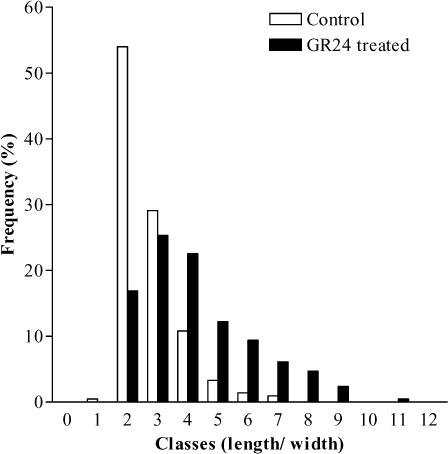
Effect of GR24 on Size of Mitochondria in Hyphae of
Gl. intraradices Stained with Mitotracker Green
Hyphae were treated with 30 nM GR24 or with 0.001% acetone for 1 h. Results are expressed in frequency (%) distribution of length/width ratios (
n = 200–220 mitochondria).